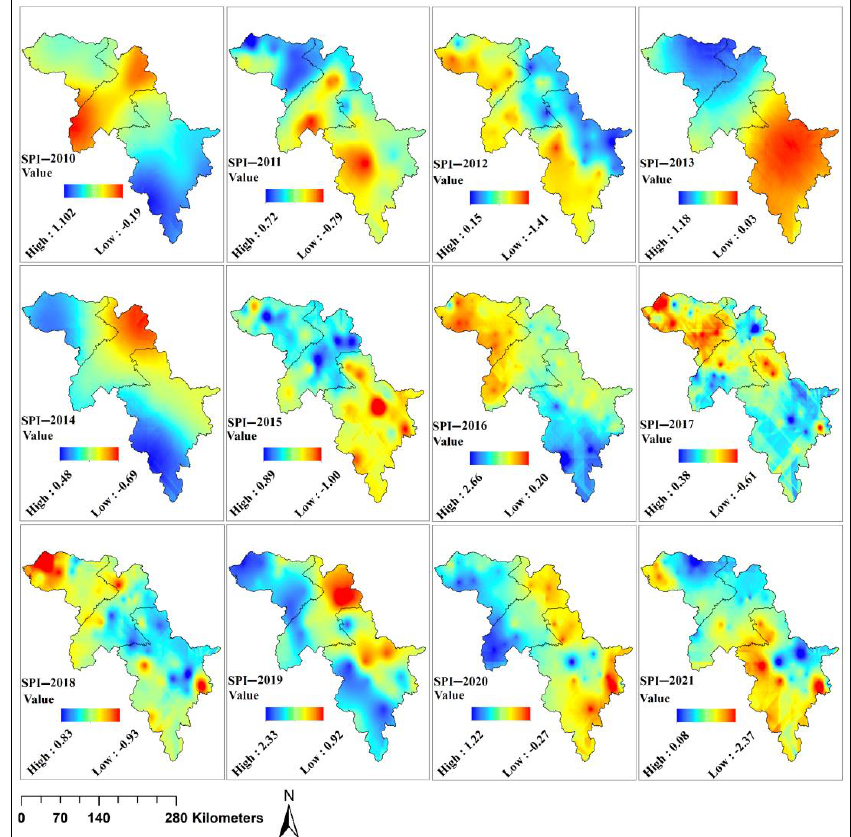
Figure 9. Temporal pattern of SPI drought and wet periods for 60 meteorological stations from 2009 to 2021.